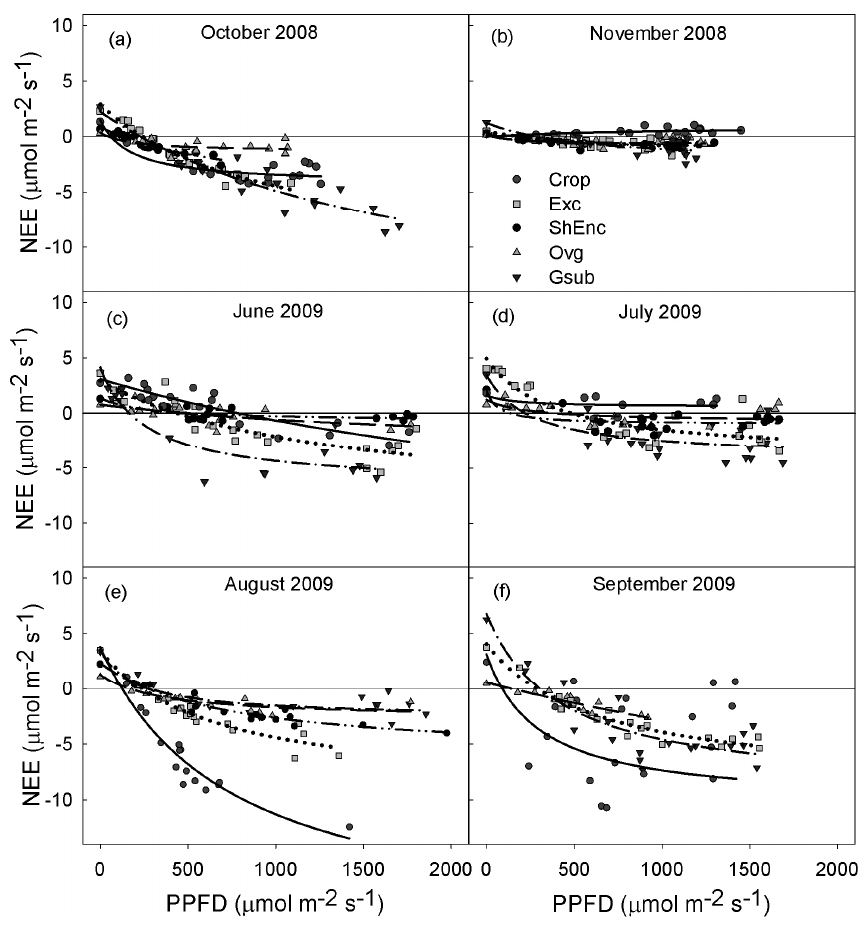
Fig. 5. Relationships between observed daytime NEE and PPFD fitted to a rectangular hyperbola function (Eq. 3) for five contrasting land use types in the shortgrass steppe in central Mexico. Line symbols correspond to the following: ··· Exc, – · – Mod, –– Ovg, – ·· – ShEnc, and —– Crop. For explanations of acronyms, refer to Fig.